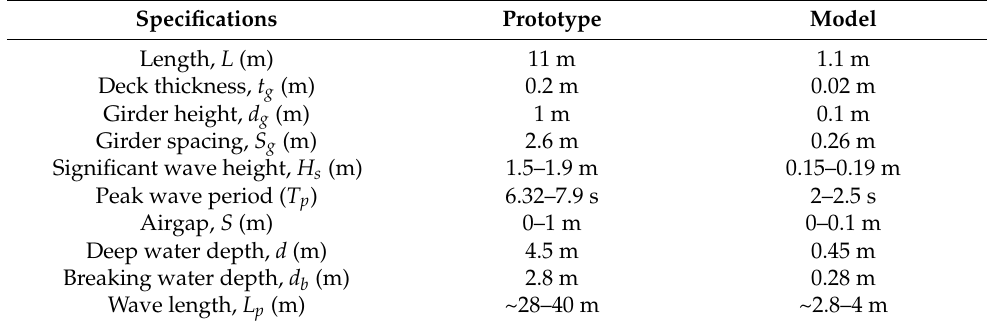
Table 1. Prototype